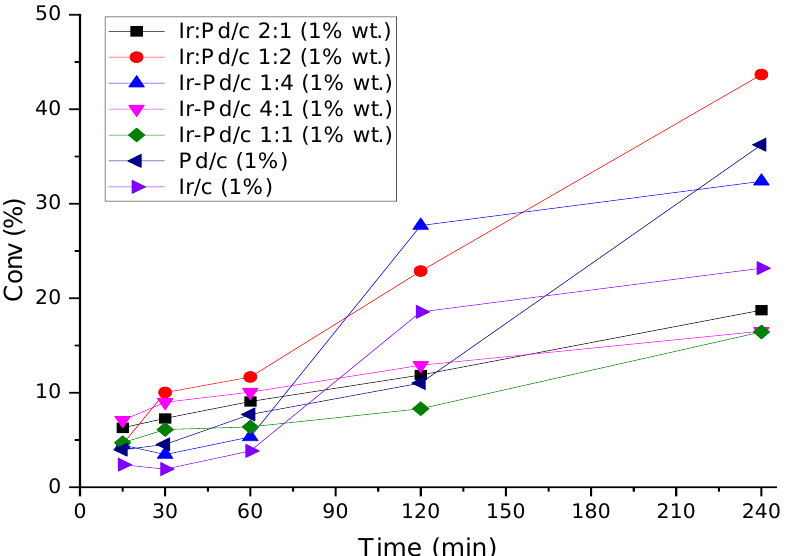
Figure 4. Catalytic decomposition of FA. Reaction conditions: FA (0.5 M), catalyst (substrate:metal molar ratio = 2000:1), 25 °C, 700 rpm, and 240 min.